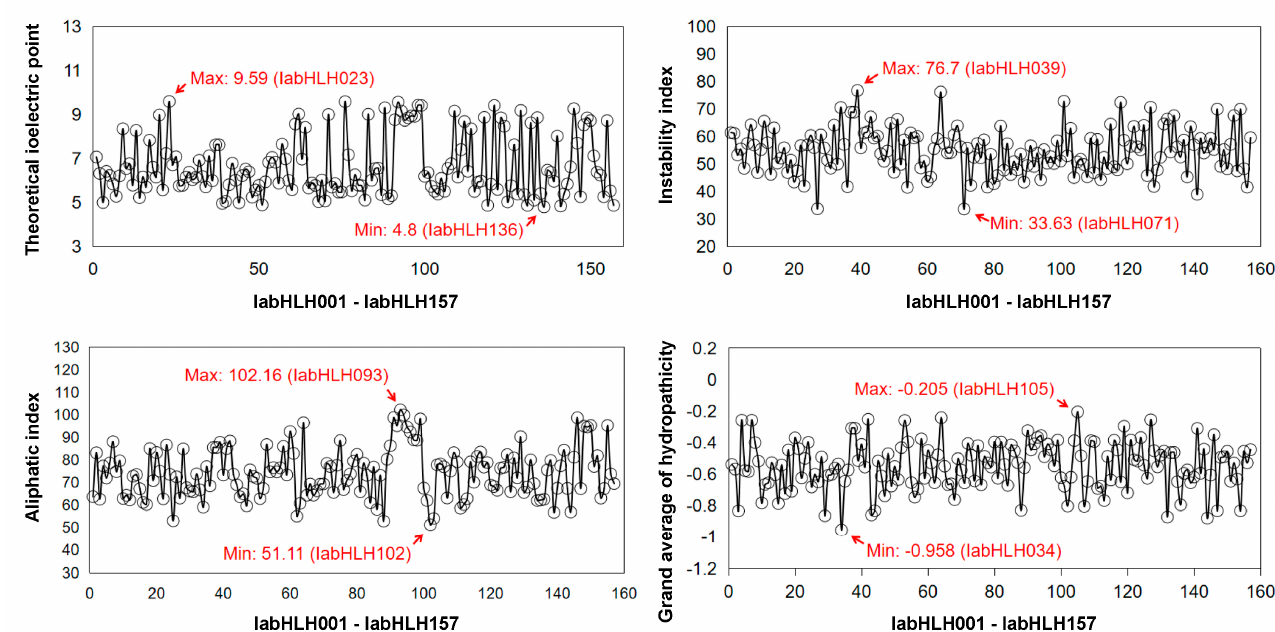
Figure 1. Identification of IabHLH genes. ( A ) Schematic diagram of the procedure for retrieving IabHLH genes from the I. aquatica genome. ( B ) The physicochemical properties of 157 IabHLH pro- teins.